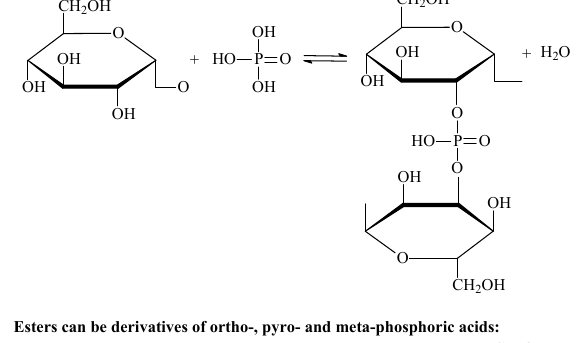
Figure 13. Phosphorous and oxygen contents together with cation exchange capacity (CEC) of H 3 PO 4 ACs as a function of heat treatment temperature. Reproduced from [78] with permission from Elsevier © 2005.